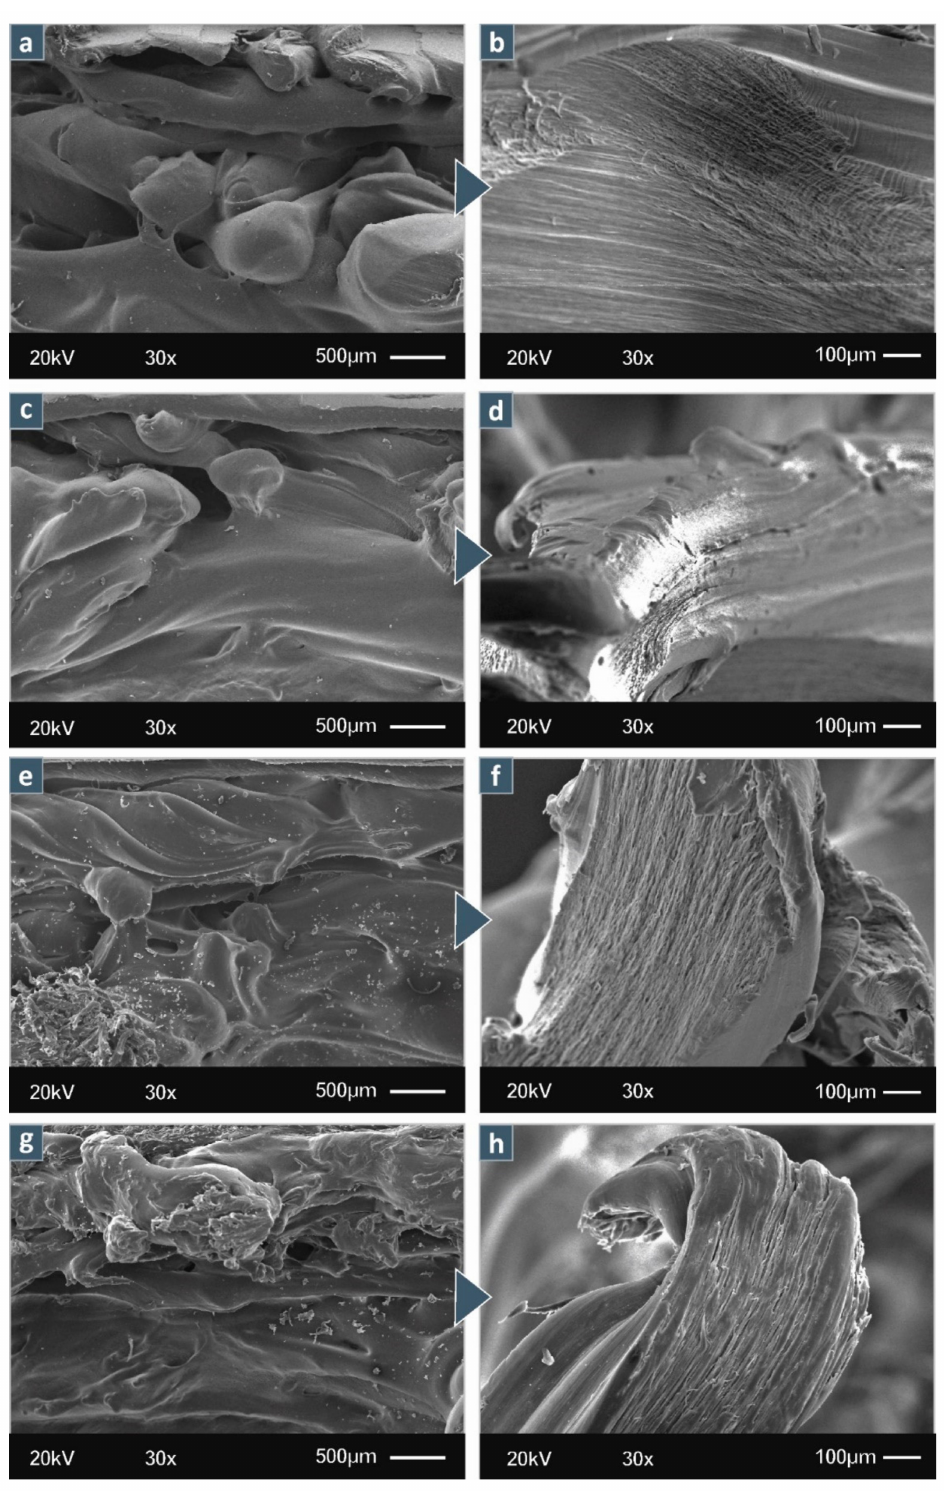
Figure 9. SEM images of ( a ) HDPE 0.5 wt.% TiO 2 printed specimen side area at 500 µ m, ( b ) HDPE 0.5 wt.% TiO 2 printed specimen side area at 100 µ m ( c ) HDPE 2.5 wt.% TiO 2 printed specimen side area at 500 µ m, ( d ) HDPE 2.5 wt.% TiO 2 printed specimen side area at 10 µ m; ( e ) HDPE 5 wt.% TiO 2 printed specimen side area at 500 µ m, ( f ) HDPE 5 wt.% TiO 2 printed specimen side area at 100 µ m, ( g ) HDPE 10 wt.% TiO 2 printed specimen side area at 500 µ m, ( h ) HDPE 10 wt.% TiO 2 printed specimen side area at 100 µ m. Note that the selected specimens are random tensile specimens in each